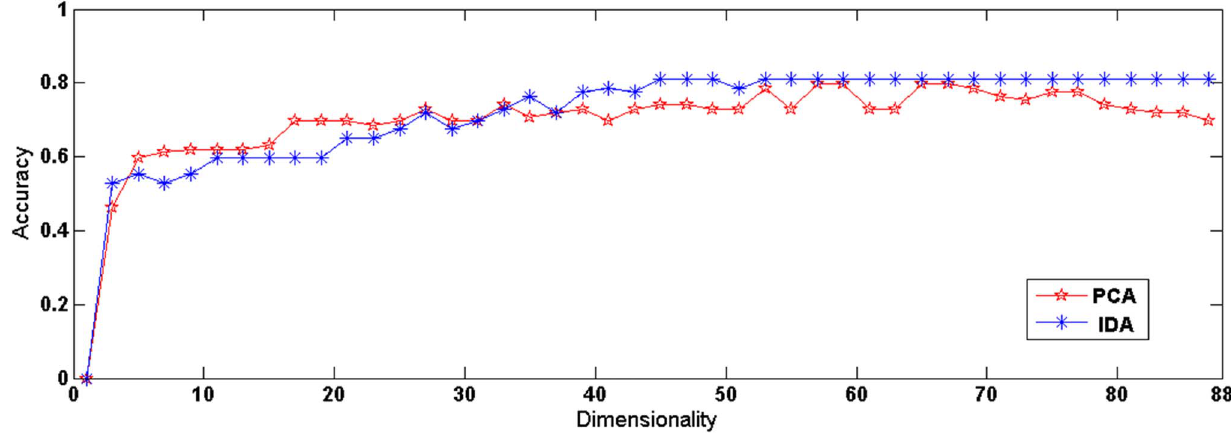
Figure 3. The curve of classification accuracy of the IDA and PCA methods.